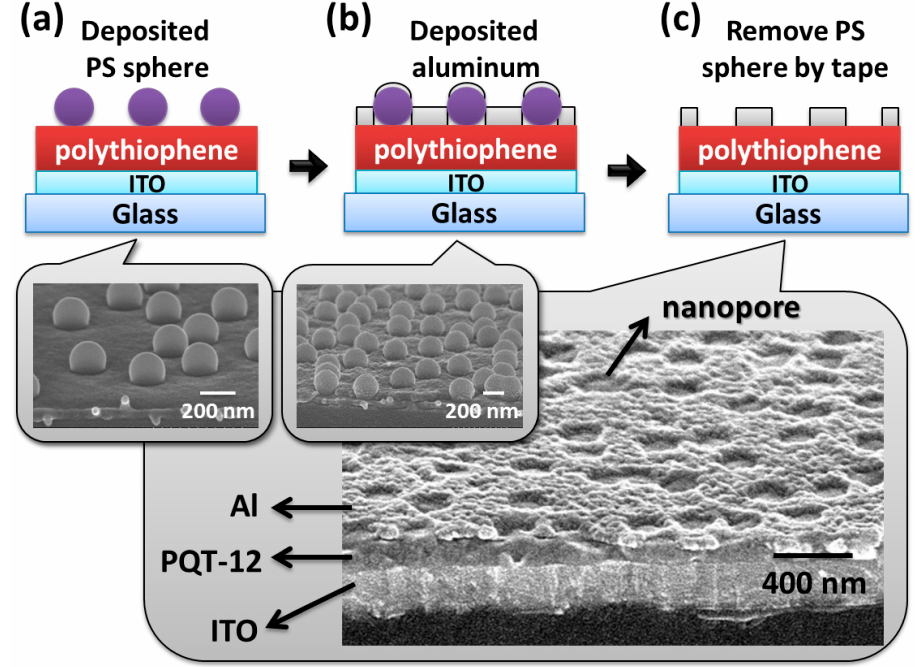
Figure 2. The fabrication process of the P3HT VNJ-diode. ( a ) Polystyrene (PS) spheres adsorbed onto P3HT; ( b ) aluminum of 40 nm was deposited as the metal electrode; and ( c ) the schematic diagram and the SEM image of the top electrode with